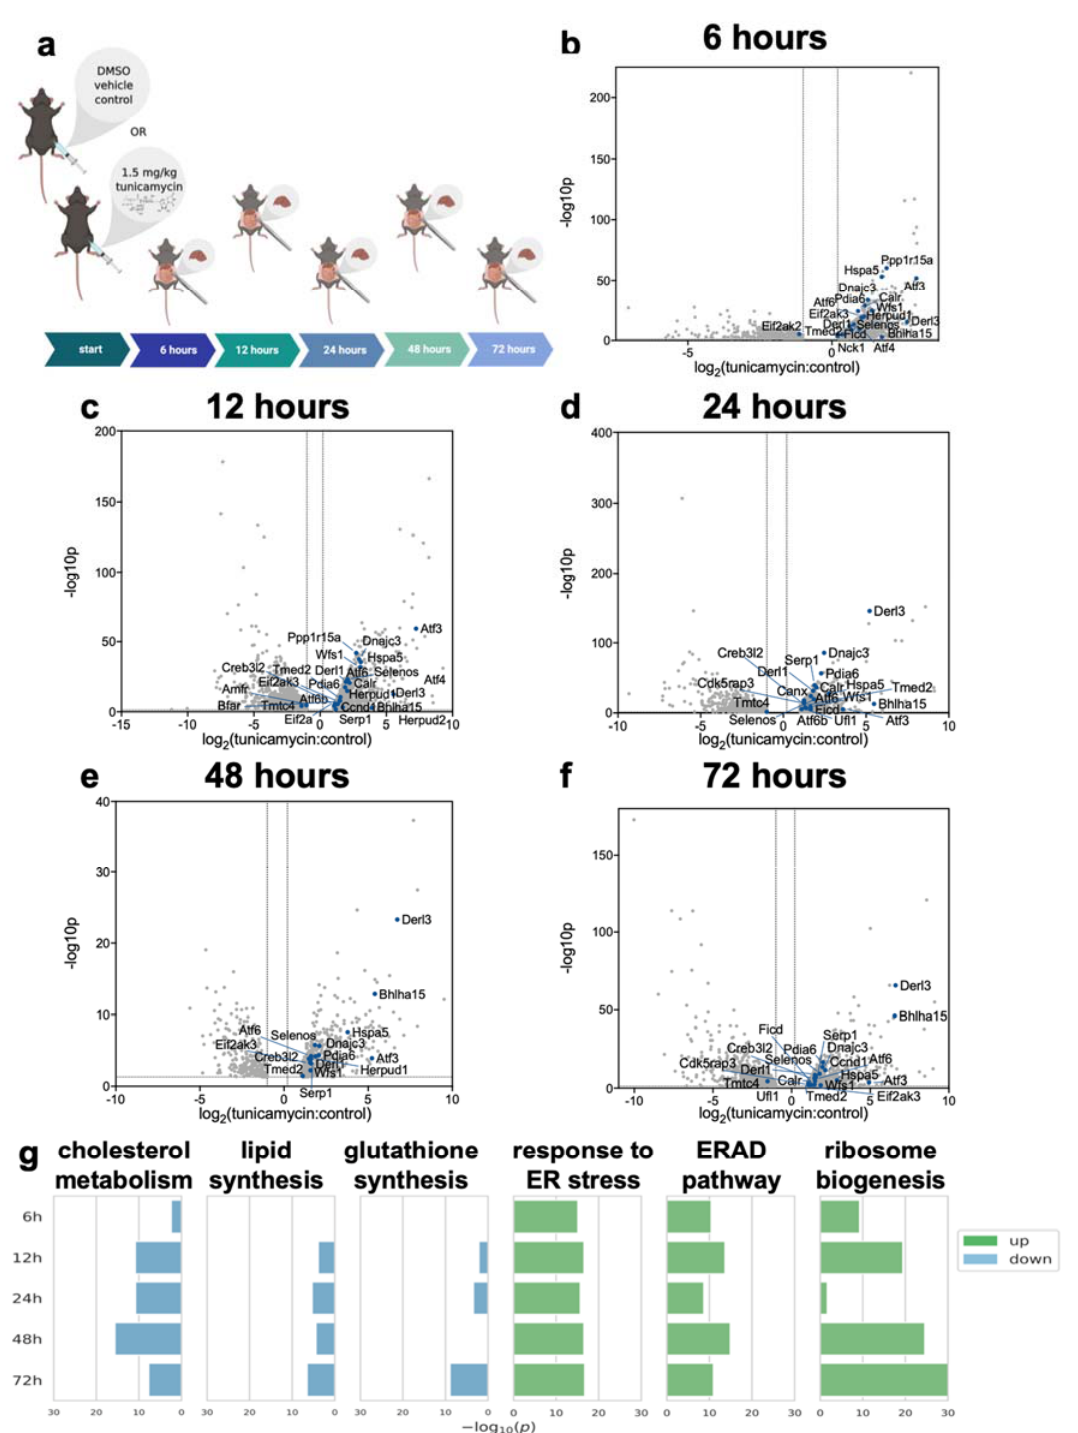
Figure 1. ( a ) Experimental overview. Mice ( n = 5 per group) were treated with either DMSO or 1.5 mg/kg tunicamycin. Tissues were taken 6–72 h post-treatment. ( b – f ) Volcano plot of all genes for which RNA-seq measured expression. Points expressed as log2 fold-change tunicamycin treated/control on x-axis and -log10 ( p -value), obtained from 2-tail t -test, on y -axis. ( g ) GO